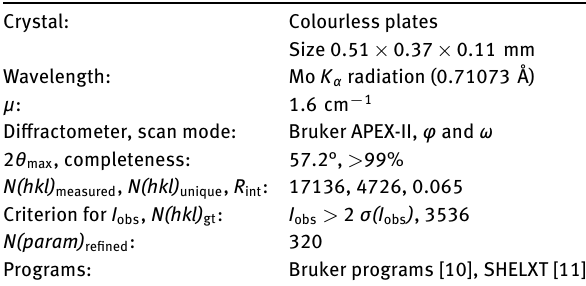
The asymmetric unit of the title compound is shown in the figure. Tables 1 and 2 contain details of the measurement method and a list of the atoms including atomic coordinates and displacement parameters. Table 1: Data collection and handling.